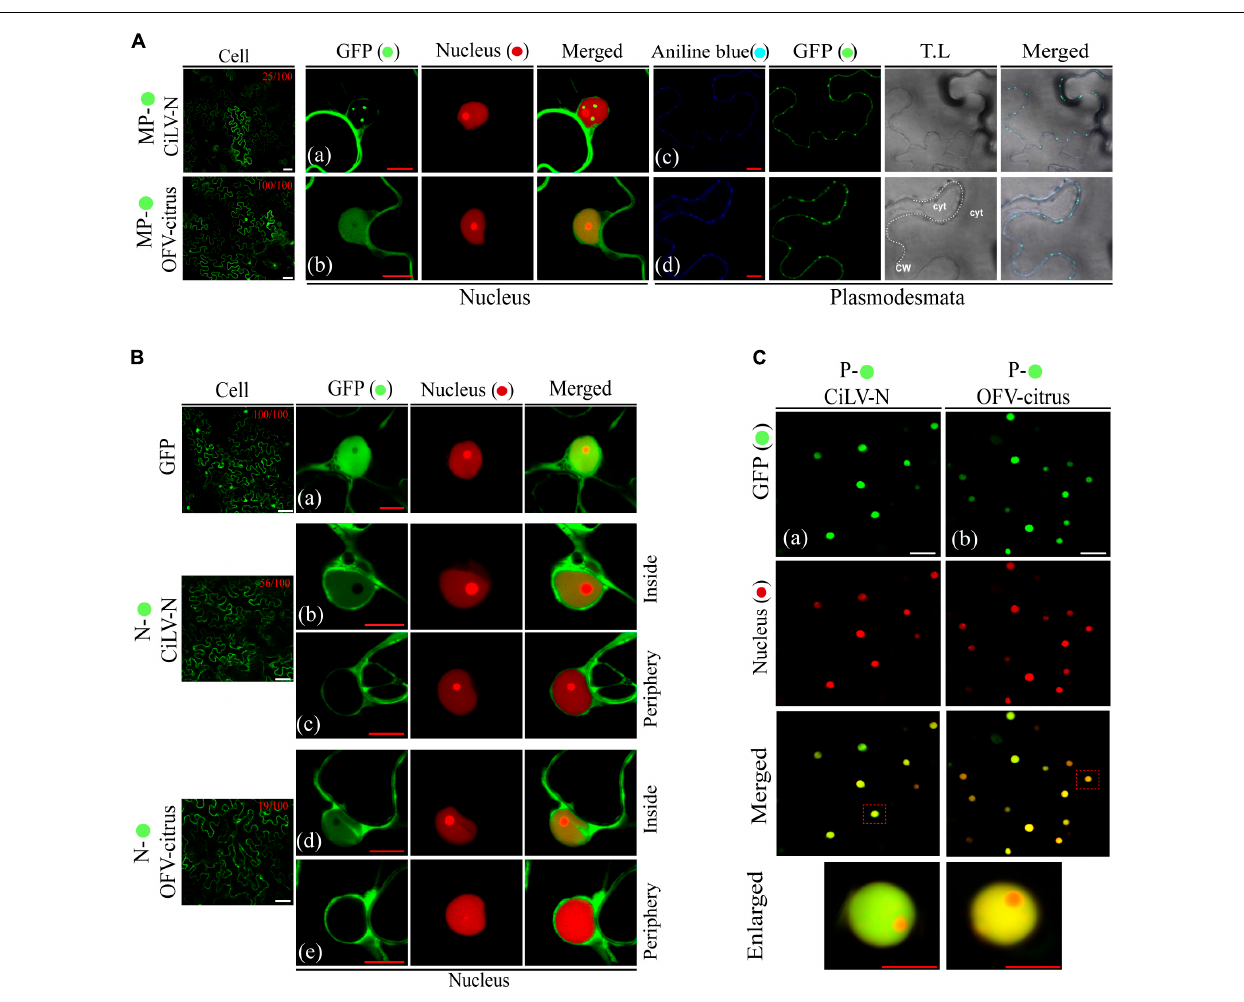
FIGURE 3 | Intracellular distribution and structure formation from ectopic expression of the dichorhavirus MPs, Ns, and Ps. The CiLV-N and OFV-citrus MP, N, and P fused at their C-termini with eGFP ( • ) were co-expressed with mRFP( • ) nucleus marker or aniline blue ( • ) fluorochrome (plasmodesmata marker) in epidermal cells of N. benthamiana . Fluorescence signals were captured 48–72 h post-infiltration with confocal microscope Zeiss LSM 780 model. The green (GFP), red (mRFP) channels, and merged images are shown for each protein expressed with nucleus marker. The blue (aniline blue), green, transmitted light (T.L), and merged images are shown for MP expressed with plasmodesma marker. The dotted line in the transmitted light image indicates the cell wall (CW). Cyt = cytoplasm. The numbers at the top of cell panels correspond to the number of fluorescent cells showing fluorescence in the nucleus, i.e., 25/100 indicates that 25 out of 100 fluorescent cells showed the presence of GFP in the nuclei. The free-eGFP expression is located as a diffuse signal distributed in the cytoplasm and nucleus (Ba) . (A) Image shows the CiLV-N MP- • expression in punctate structures into the nuclei co-localizing with nuclei marker (a) , and a signal distributed at cell membrane periphery, colocalized in punctate structures with plasmodesmata along the cell periphery (c) . (b) OFV-citrus MP- • expression in a diffuse signal evenly distributed into the nucleus co-localizing with nuclei marker, and co-localizing in punctate structures with plasmodesmata along the cell periphery (d) . (B) CiLV-N and OFV-citrus N- • expression in a diffuse signal distributed within some cell nuclei co-localizing with nuclei marker ( b and d ). GFP-empty nuclei are also visualized ( c and e ). N- • signal is also distributed throughout the cytoplasm for both viruses. (C) The P- • expression is visualized exclusively in cell nuclei colocalized with nuclei marker for both CiLV-N (a) and OFV-citrus (b) . Images below show in higher magnification the respective nuclei indicated in the red dashed boxes. Red and white bars correspond to 10 and 50 µ m,